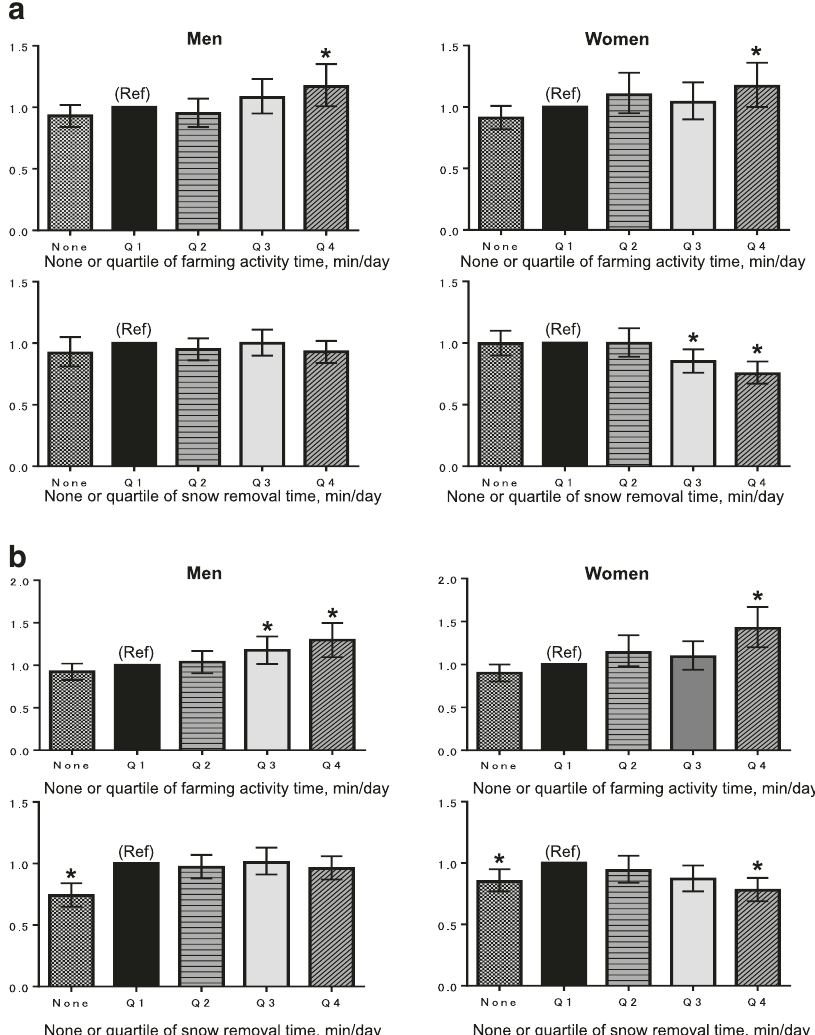
Fig. 4 The adjusted odds ratio of happiness and ikigai according to quartile of time spent on farming activity and snow removal. The adjusted odds ratio (95% CI) of happiness (a) and ikigai (b) are calculated by multivariable ordinal logistic regression analysis, by sex. The reference group is quartile 1, which the shortest amount of time on each physical activity. *95% con fi dence intervals (CI) of odds ratios do not include